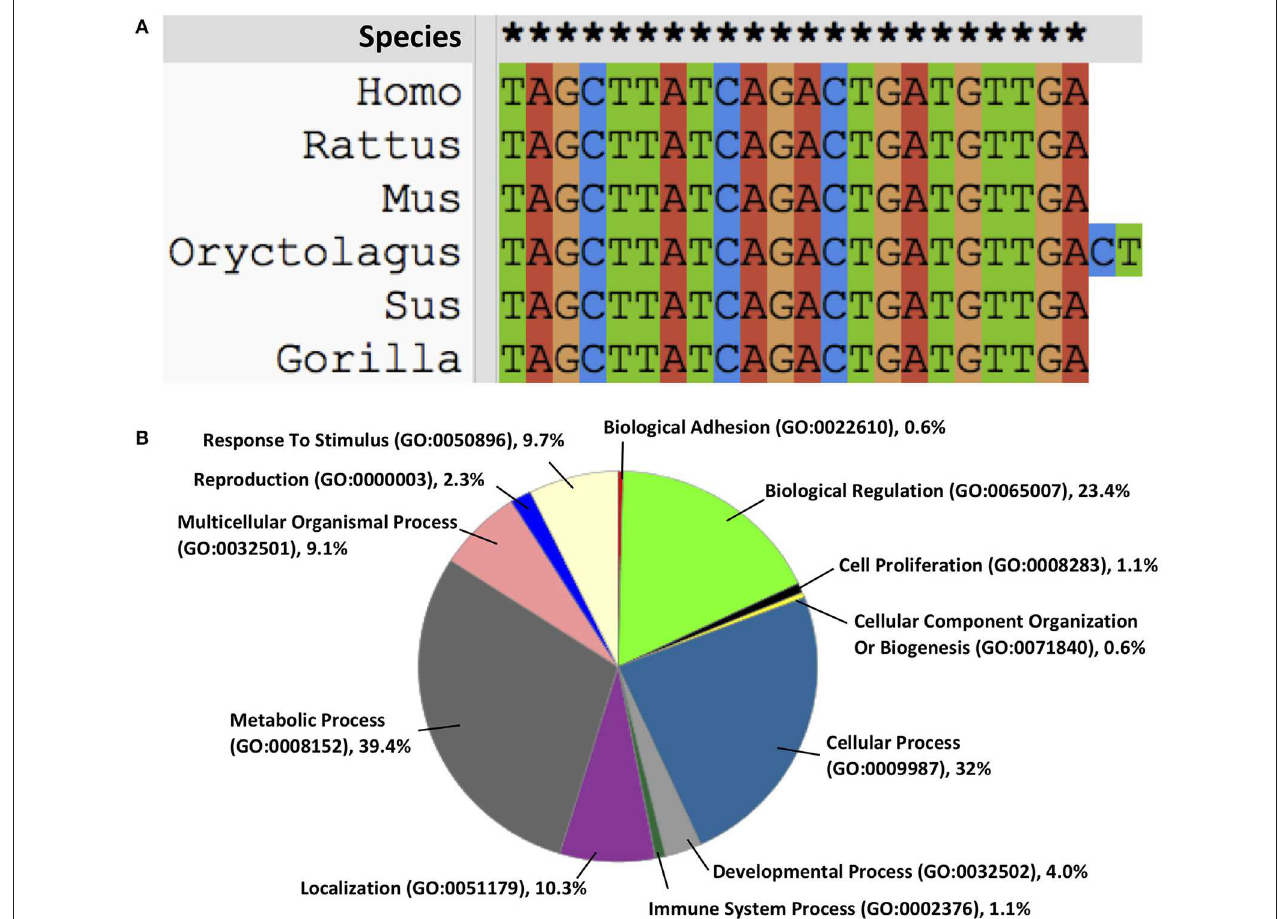
FIGURE 1 | (A) miR-21 is highly conserved across the species, (B) the functions of miR-21 on intracellular biological processes.